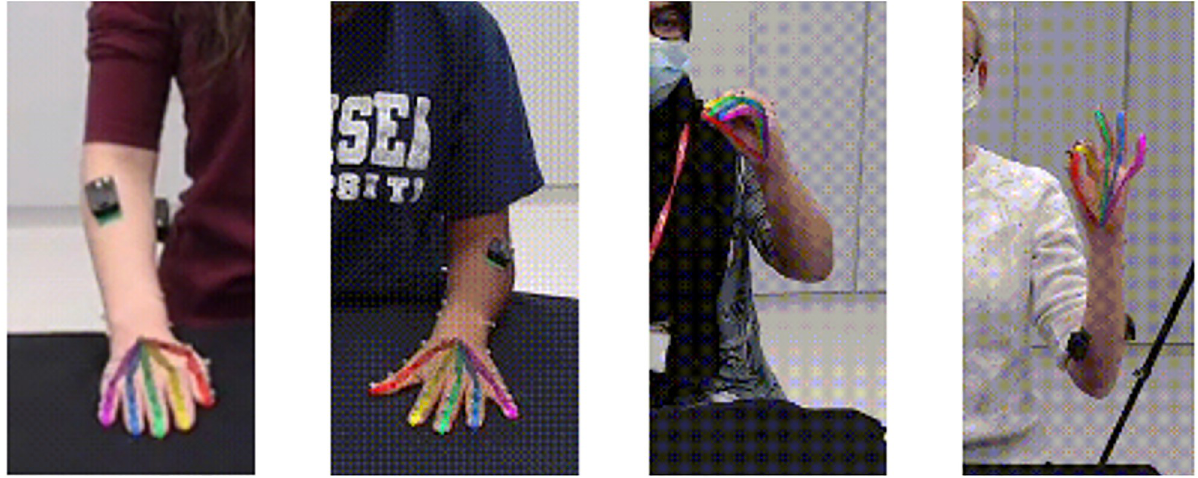
Fig 3. Keypoint visualization. Output from OpenPose that illustrates the inferred keypoints overlapped onto the image frames for four representative participants.